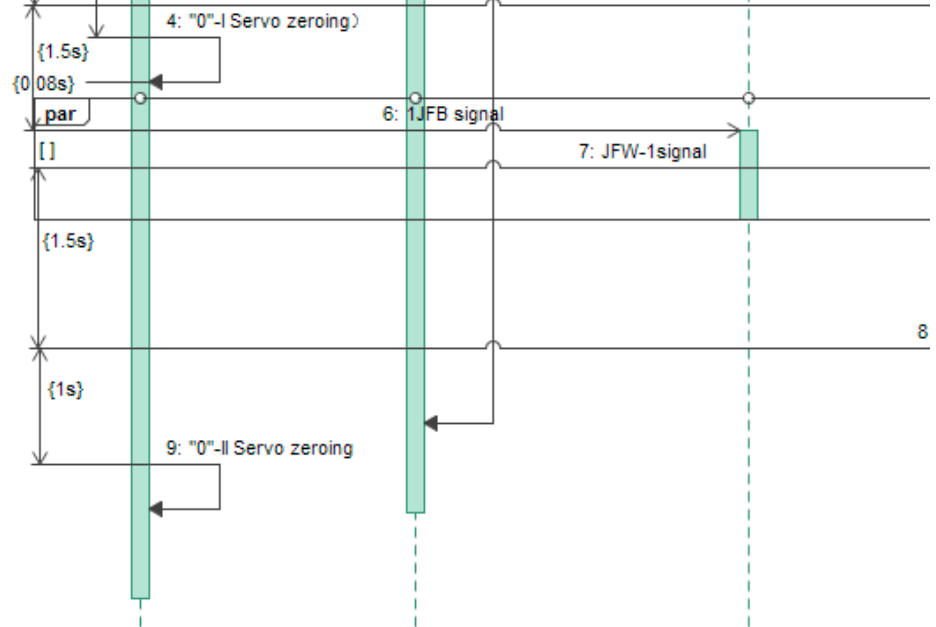
Figure 16. Flight procedures.